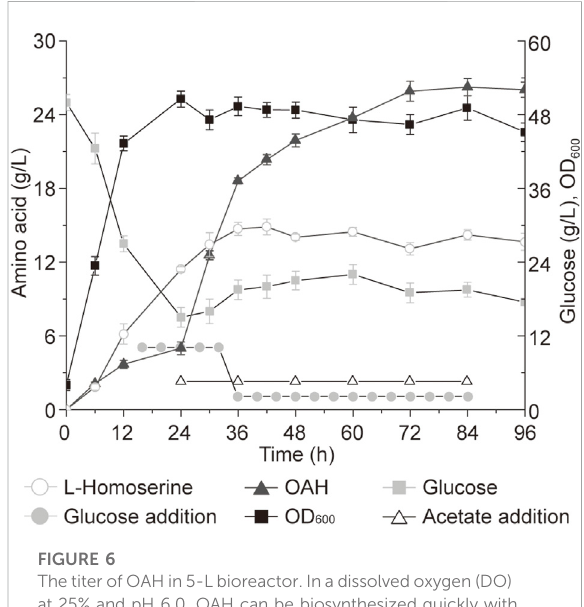
FIGURE 6 ThetiterofOAHin5-Lbioreactor.Inadissolvedoxygen (DO) at 25% and pH 6.0, OAH can be biosynthesized quickly with glucose addition in a 5-L bioreactor. Error bars are standard deviation of triplicate